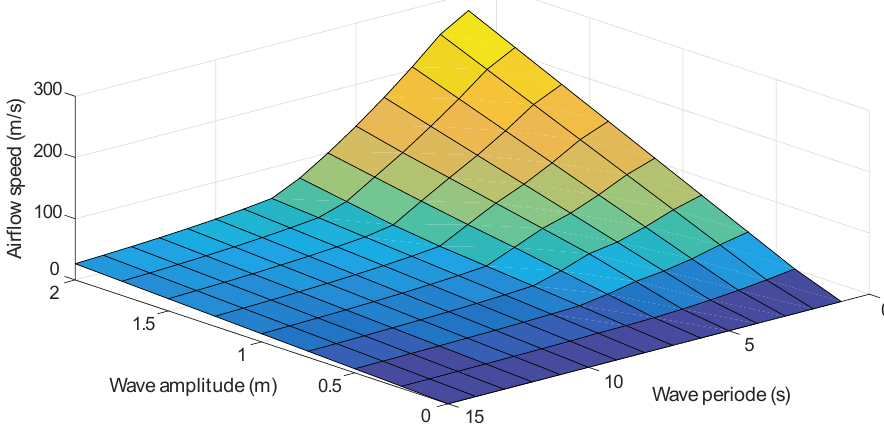
Figure 4. Airflow speed variation for different wave amplitudes and